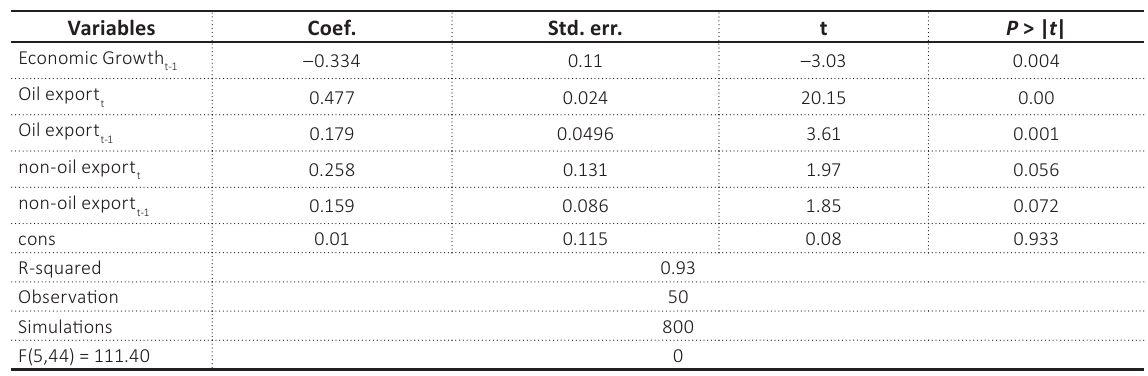
Table 5. Dynamic ARDL